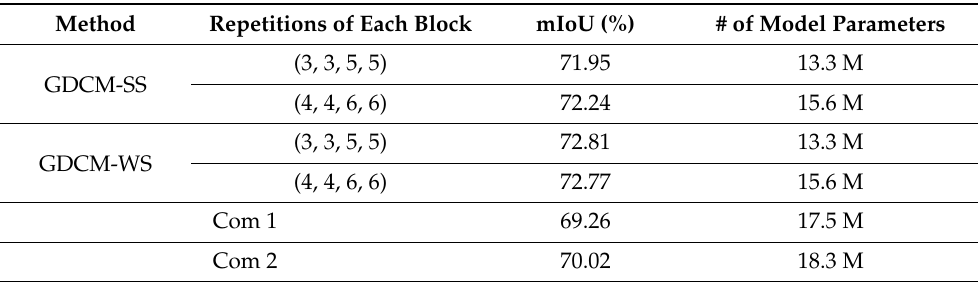
Table 8. Comparison of accuracy by model depth per method.